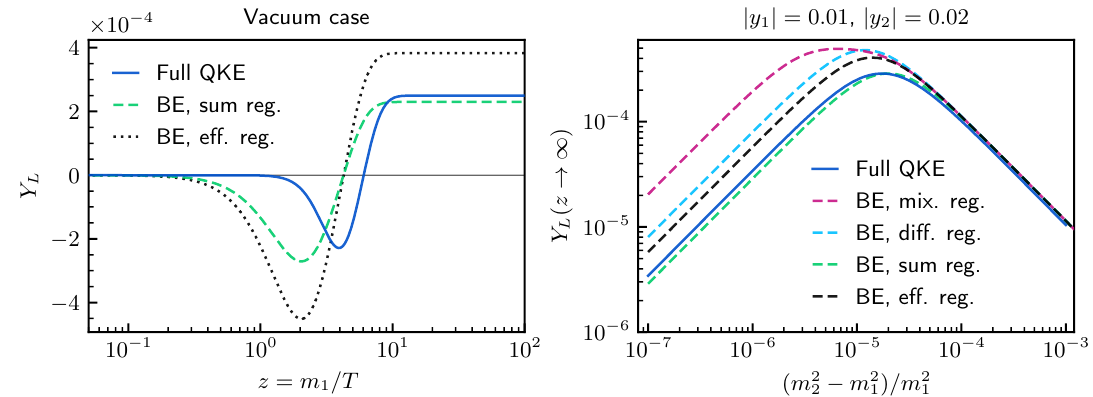
Figure 12. Comparison of the effective sum regulator with the other results in the weak washout case with | y 1 | = 0 . 01 and | y 1 | = 0 . 02 . In the left panel we took ∆ m 2 10 − 5 near the resonance maximum. We used vacuum initial conditions in both panels, and other parameters have the benchmark values